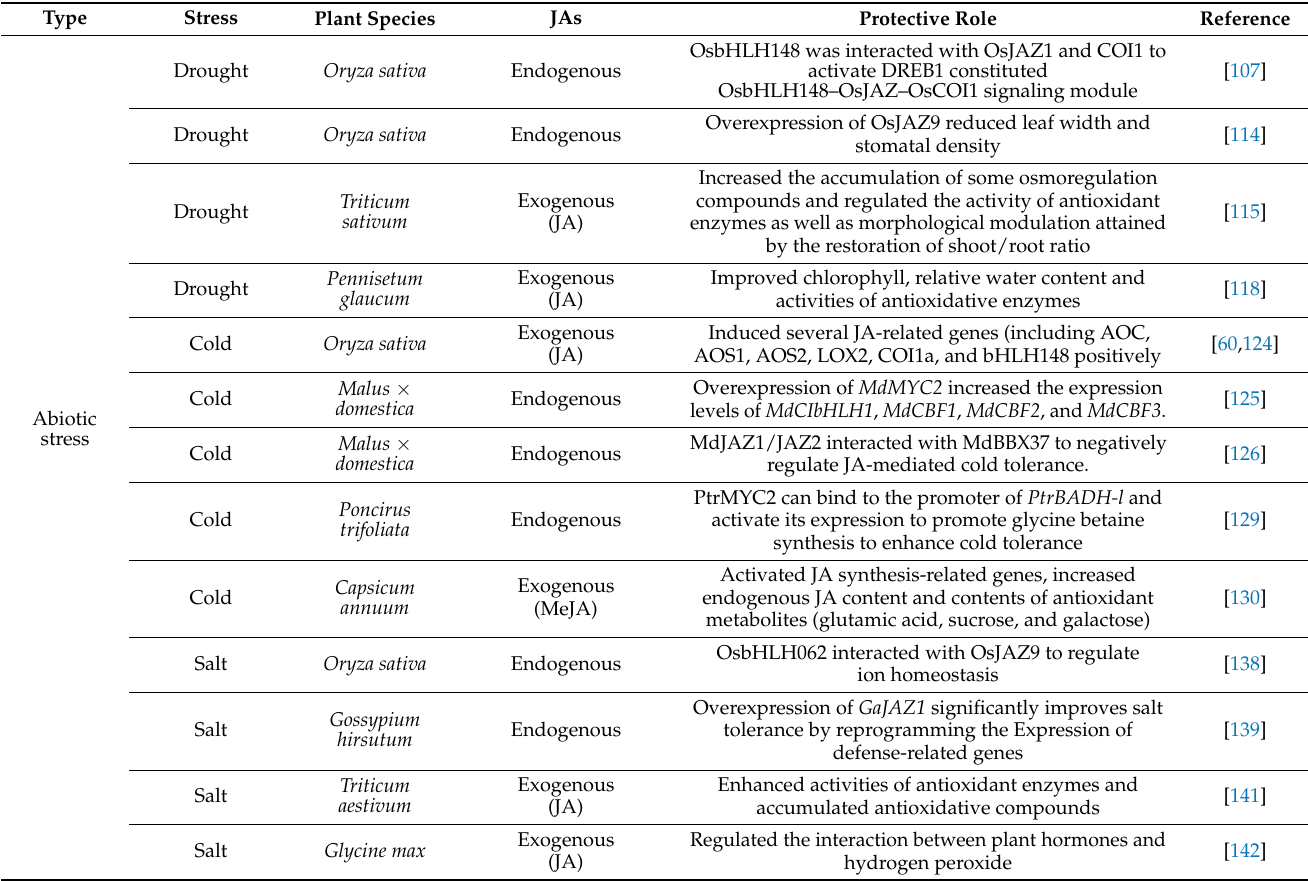
Table 1. Regulation mechanism of endogenous and exogenous JAs in response to abiotic and biotic stresses.